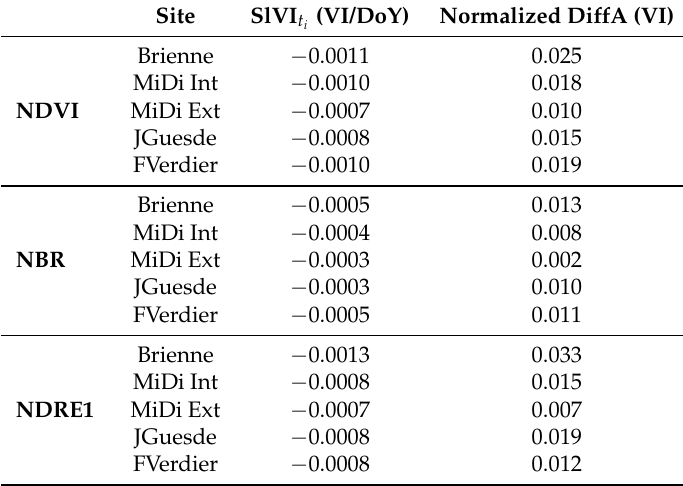
Table 5. Mean of the intra-annual disturbance criteria on S-G filtered phenological curves for NDVI, NBR and NDRE1 and for the five studied